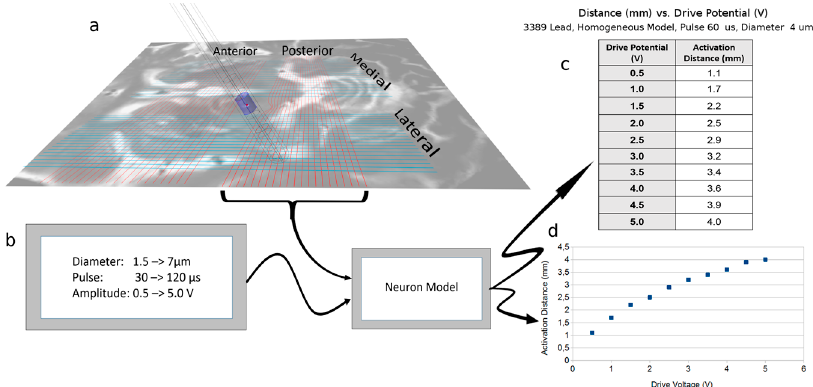
Figure 3. Neuron model application and single calculation run. ( a ) The voltage gradient extraction lines generated from FEM (COMSOL) simulation. The posterior lines have been replaced by the real potential values along the lines, as can be seen by the deviation of the line close to the electrode; ( b ) Input to the neuron model and the model block [14]; ( c ) Data points output from the Neuron model for the 3389 lead, with the specific input parameters of FEM output (homogeneous model and 3389 lead), pulse length of 60 µs, and neuronal diameter of 4 µm. The output is the distance from the surface of the lead to the distance where activation no longer happens; ( d ) The graphical implementation of the one data set.